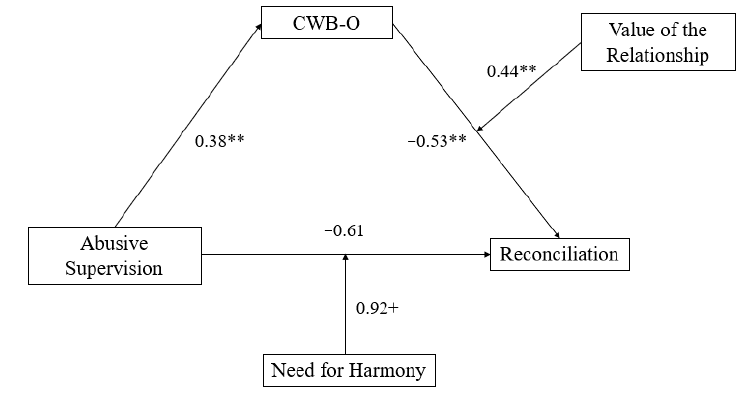
Table 5. Study 1 Indirect Effect, Direct Effect, and Total Effect.